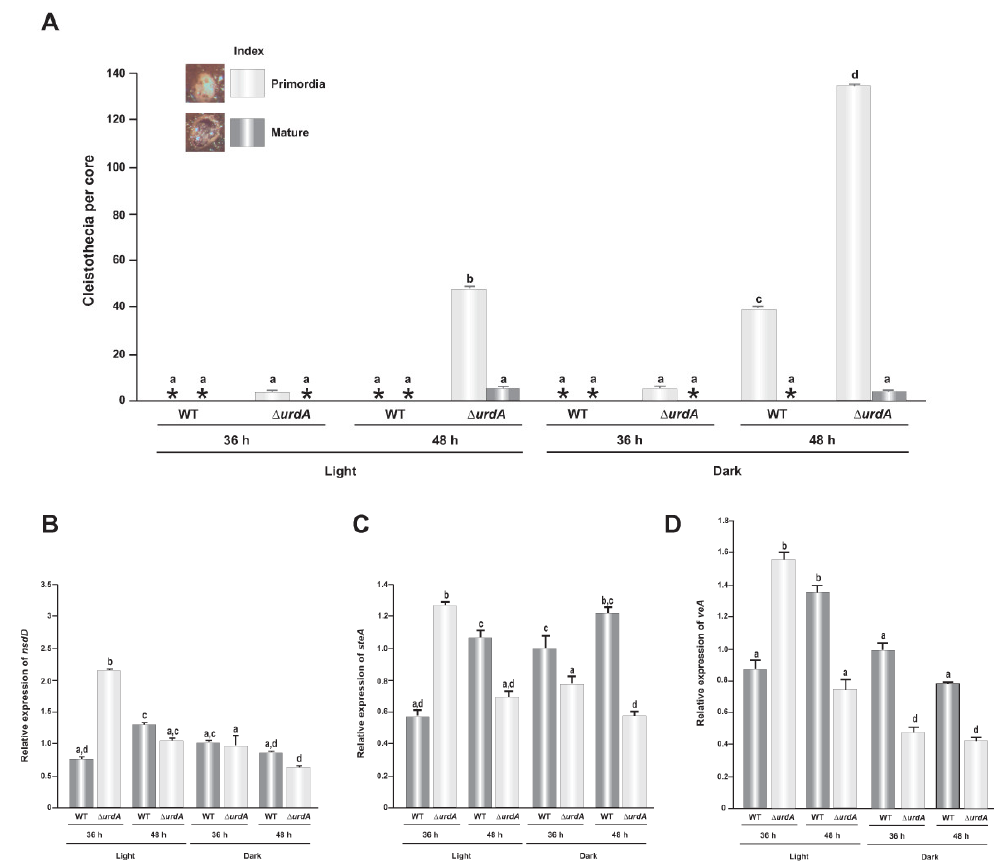
Figure 5. urdA represses sexual development. ( A ) Quantification of cleistothecia (both immature and mature) in 36 h and 48 h cultures grown on solid GMM in light and dark. Asterisks indicate not detected. Top-agar inoculated cultures were used to analyze the expression of nsdD ( B ) steA ( C ) and veA ( D ) . Values are means of three replicates and error bar indicates standard errors. Different letters above the bar graphs represent significantly different values ( p ≤ 0.05).